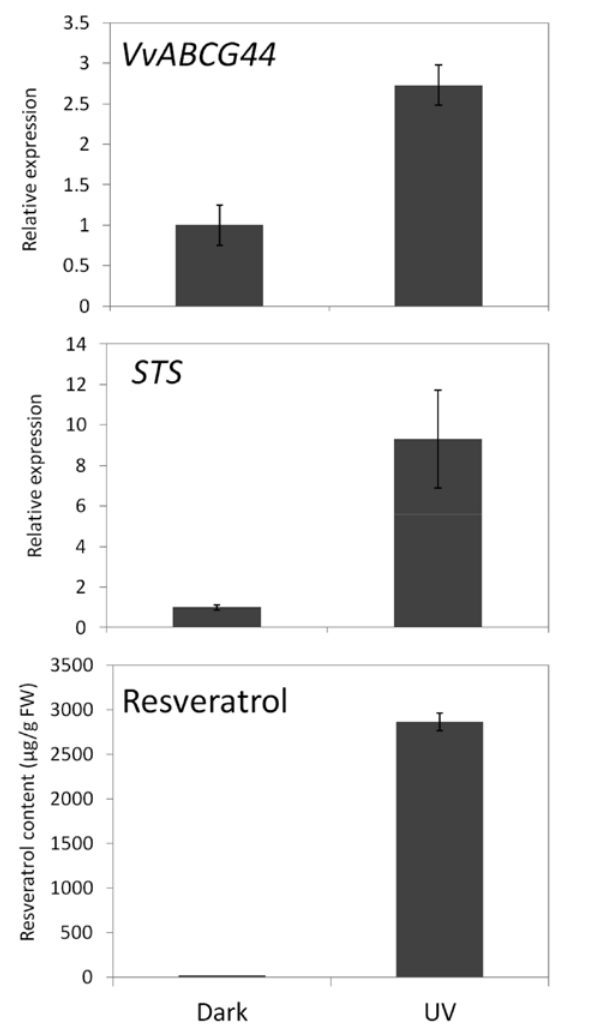
Fig. 4 - Expression of STS,VvABCG44 and resveratrol content in the grape berry skin after UV irradiation. mRNA levels of STS and VvABCG44 were detected by quantitative PCR. Actin was used as an internal control. Each value represents mean ± SE of three independent experiments. Resveratrol content was assayed by LC-ESI-Q-TOF/MS system in negative ion mode. Each value represents mean ± SE of six independent measurements.